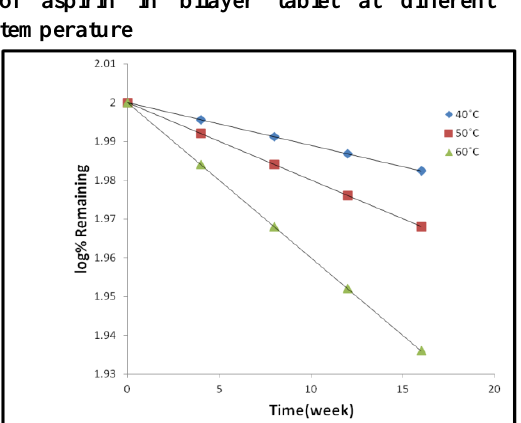
Figure10:First order plot for the degradation of clopidogrel in bilayer tablet at different